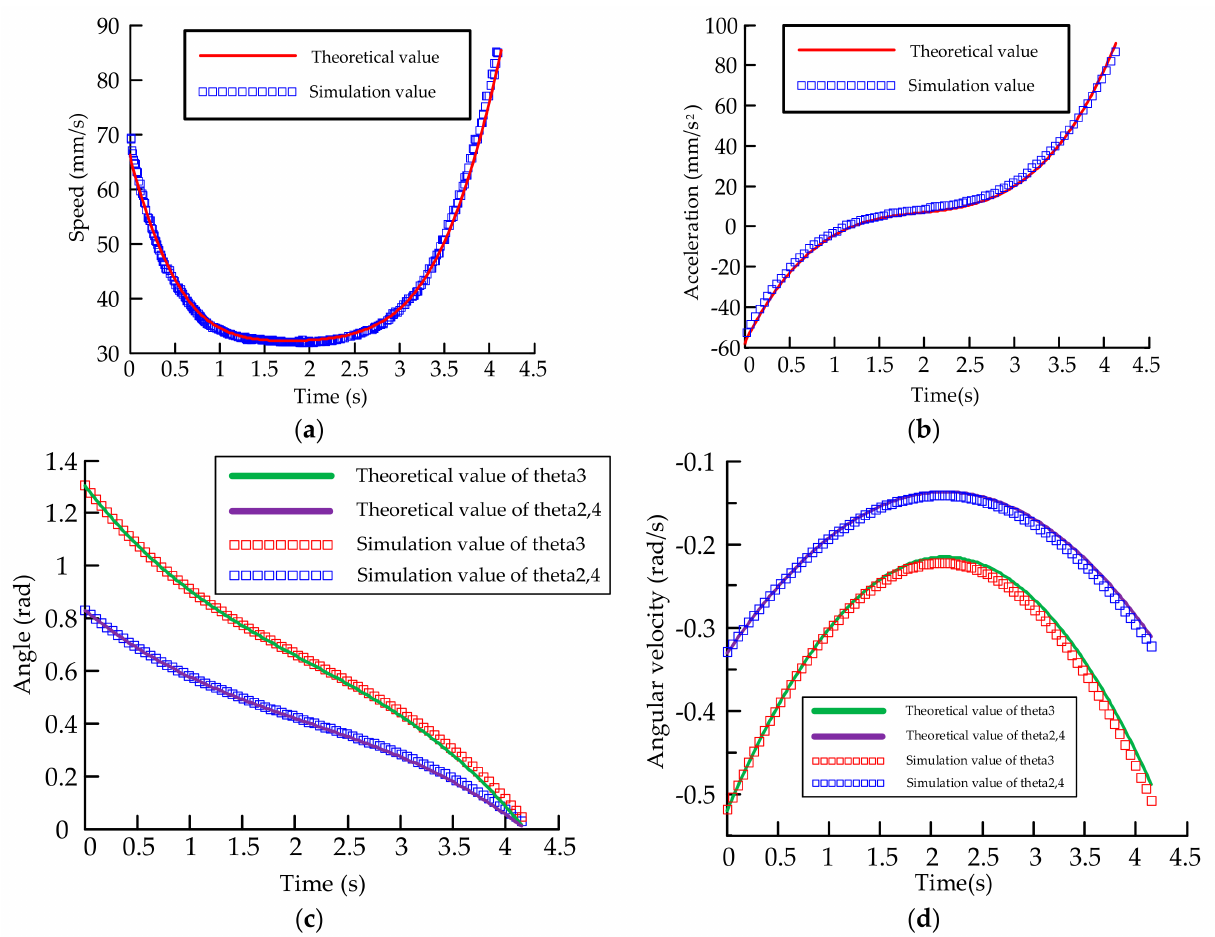
Figure 6. Analysis of the key point in the scheme. ( a ) Speed change of the finger sleeve; ( b ) acceleration speed change of the finger sleeve; ( c ) angle change of the three finger joints; ( d ) angular velocity change of the